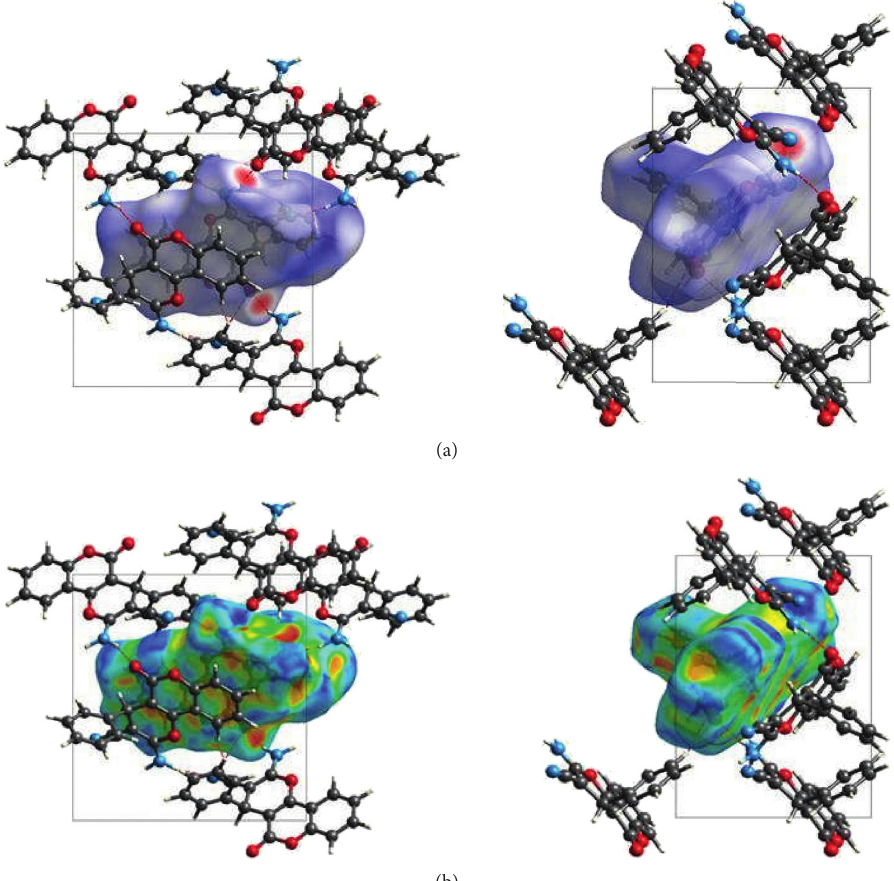
Figure 5: Graphical plots of Hirshfeld surfaces of Chrom-D mapped with (a) d axis (right).